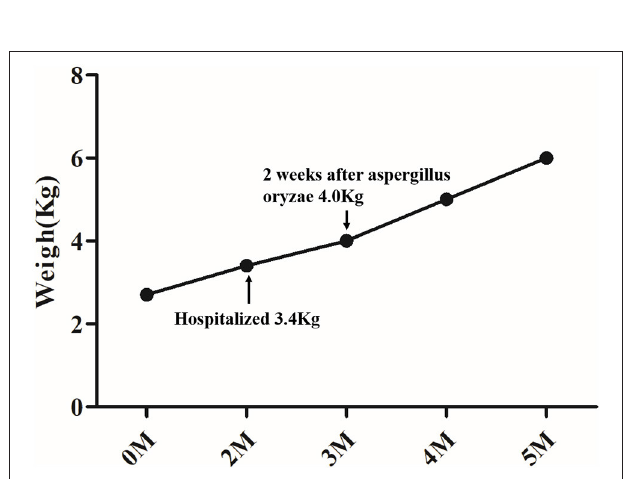
FIGURE 2 | Weight change of the